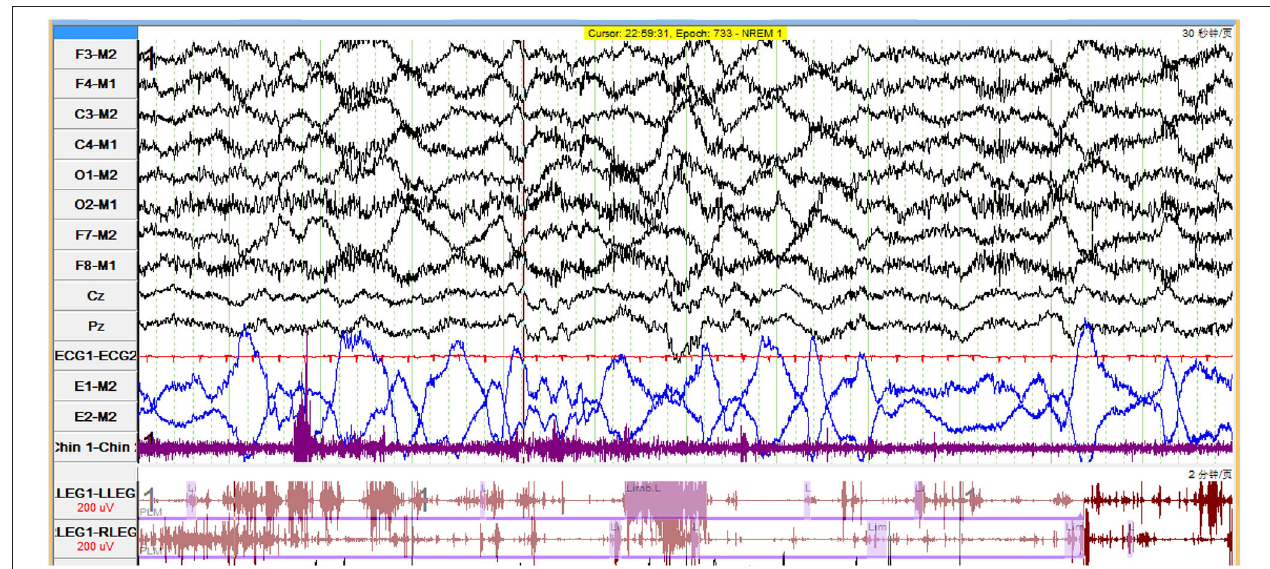
FIGURE 2 | Polygraphic recording in a patient with LGI1-antibody encephalitis who had status dissociatus showed dominated slow eye movements interspersed with rapid eye movements. LGI1, leucine-rich glioma-inactivated protein 1.